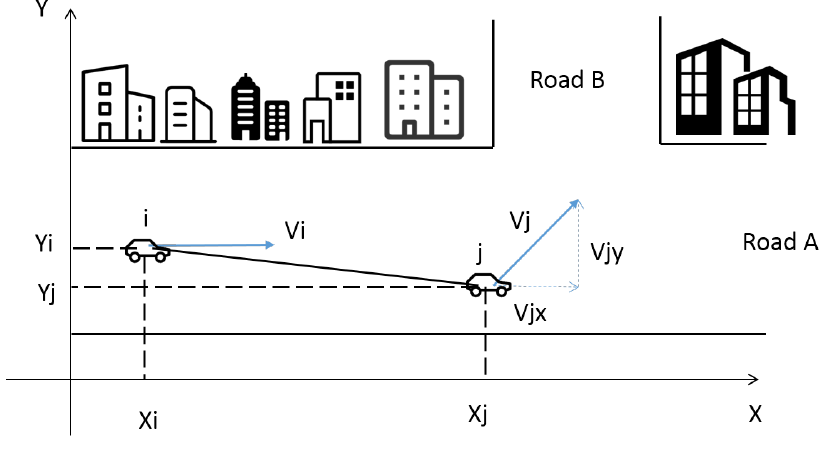
Figure 4. Node movement